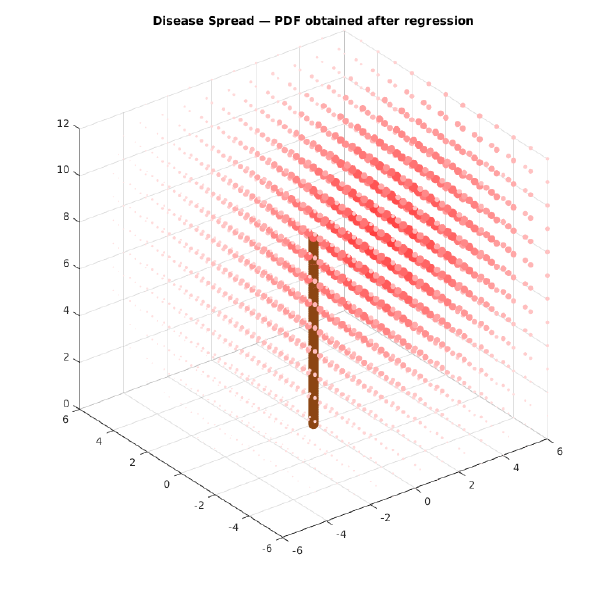
Figure 32. Estimated PDF display. The larger and more colorful red dots have a bigger probability density. The brown cylinder represents the main tree